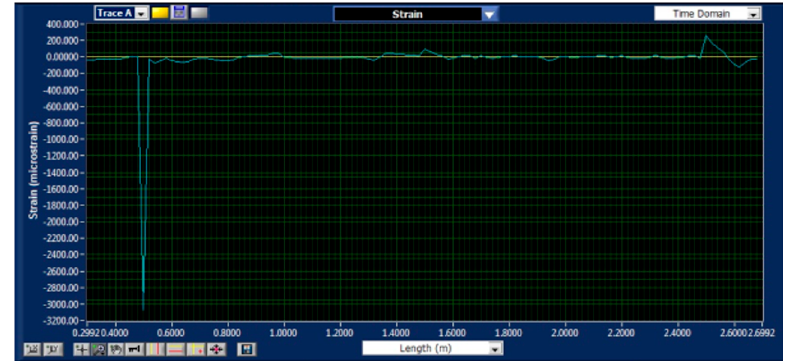
Figure 15. ( a ) Yellow trace displays strain before sensor failure. ( b ) Blue trace displays strain after sensor failure due to corrosion.